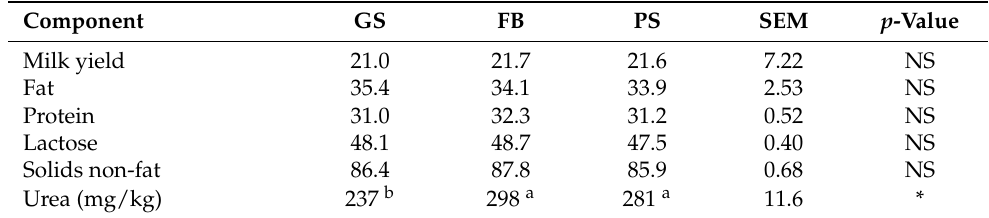
Table 7. Production (kg/day) and composition (g/kg) of milk from dairy cows with feeding diets based on grass silage (GS), faba bean silage (FB), or field pea silage (PS). Component GS FB